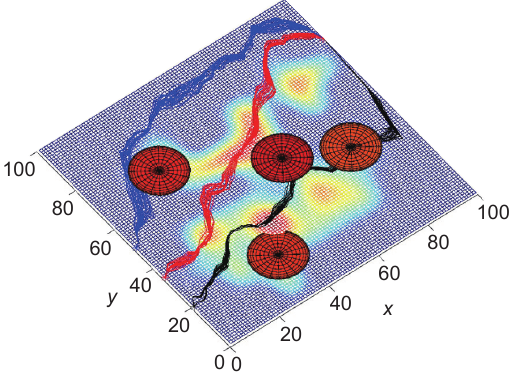
Fig. 7 Top view of the